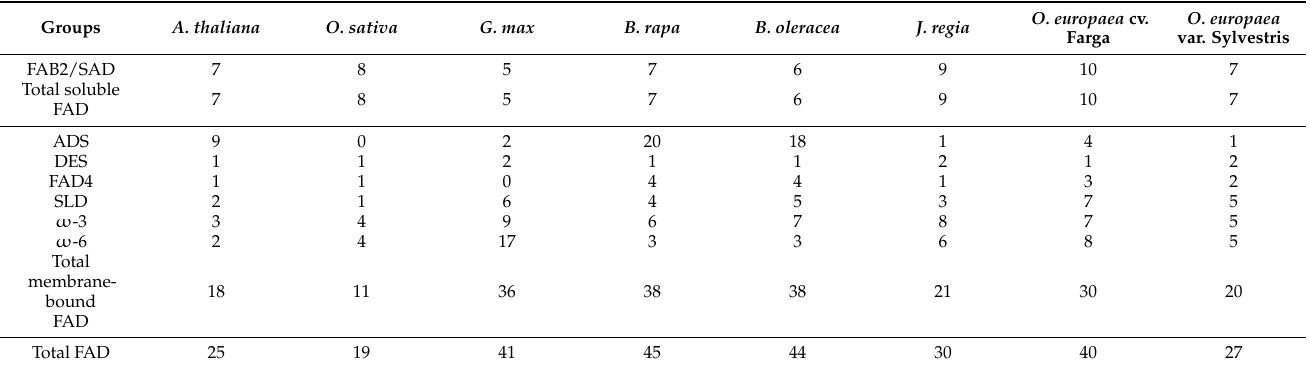
Table 2. The numbers of FAD genes in different diploid plants 1 .